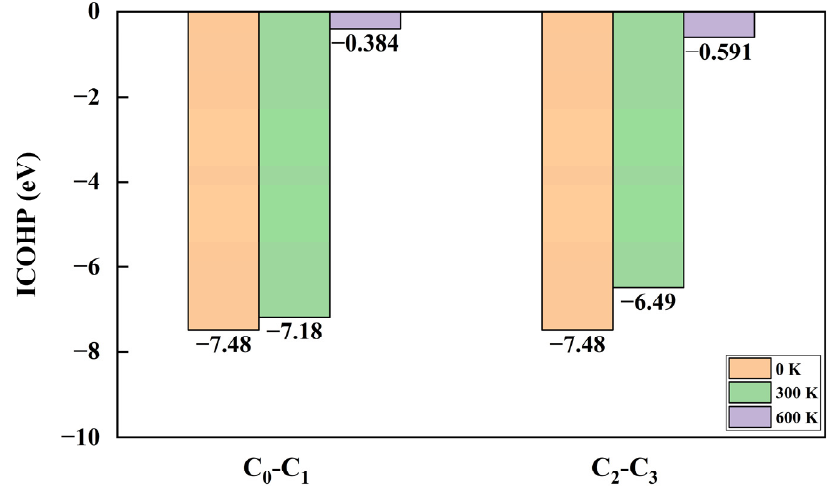
Figure 7. The ICOHP value of C 0 -C 1 and C 2 -C 3 bonds of at 0 K, 300 K, and 600 K.